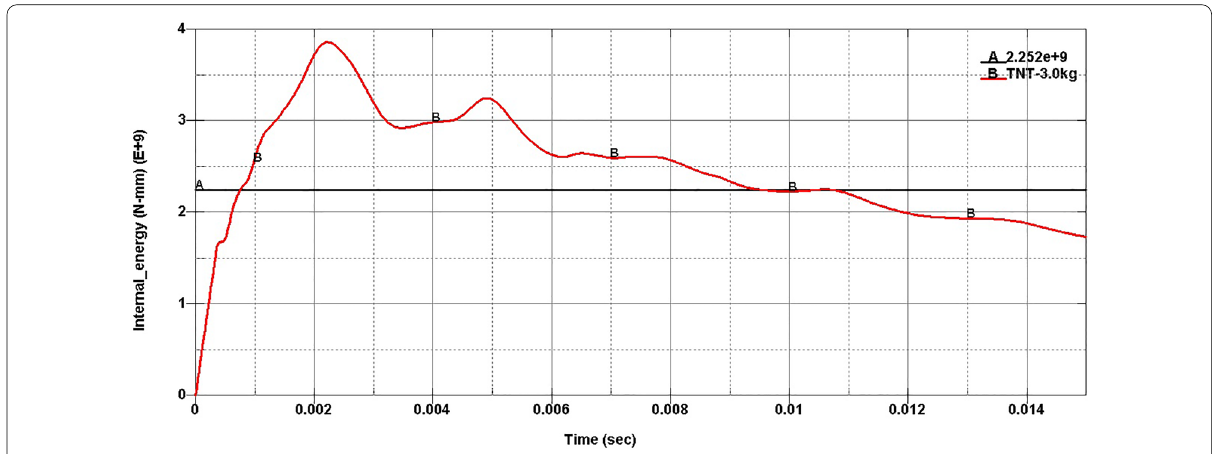
Fig. 20 TNT 3 kg afterburning start time and end time.